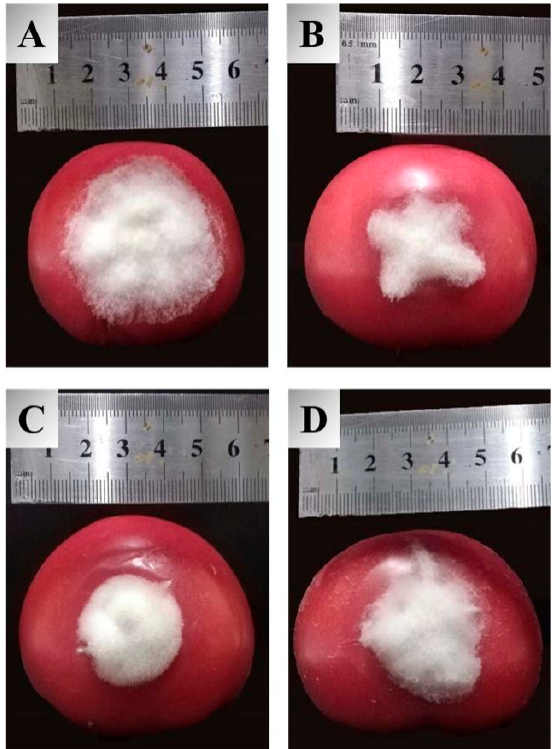
Figure 2. Protective efficacy of compound 3c , resveratrol, and carboxin against tomato gray mold at 400 µg/mL, ( A ) blank control, ( B ) 3c , ( C ) resveratrol, ( D ) carboxin.